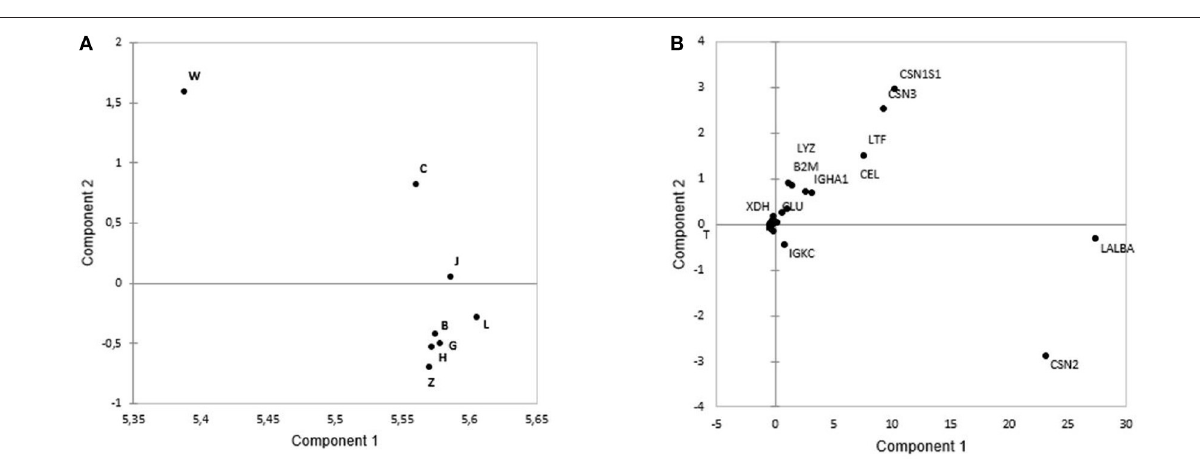
FIGURE 2 | The principal component analysis (PCA) plots based on protein intensity of: (A) B, Beijing; G, Guangzhou; C, Chengdu;W, Weihai; L, Lanzhou; J, Jinhua; Z, Zhengzhou, and H, Harbin. Weihai, Chengdu, and Jinhua are located in the same pool, while Lanzhou, Beijing, Guangzhou, Harbin, and Zhengzhou are located in the second pool. (B) Loading plots based on the intensity of the proteins showed that CSN2, LALBA, and IGKC were the abundant proteins in the second pool, while the first pool had abundance of CSN1S1, CSN3, LTF, LYZ, B2M, IGHA1, CEL, CLU, B2M, and